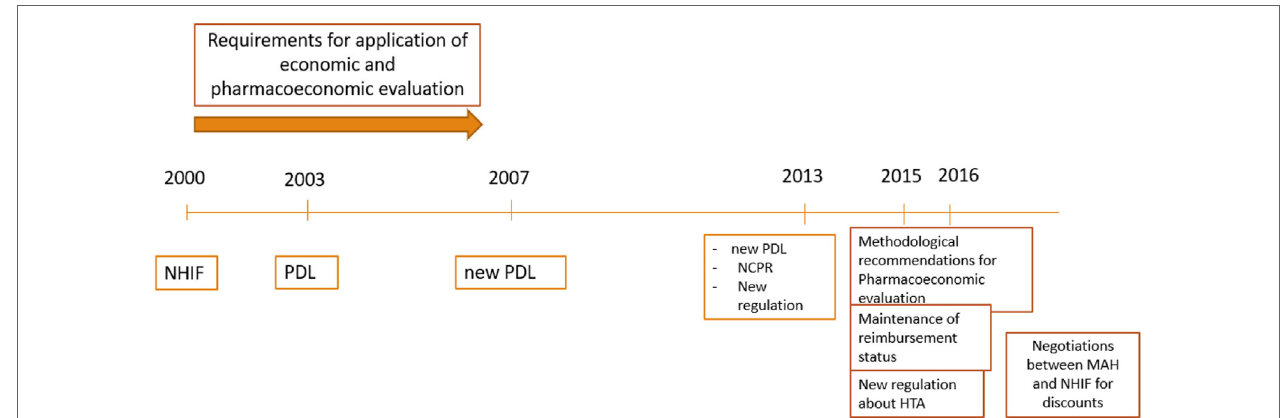
Figure 1 | Regulatory development of reimbursement procedures in